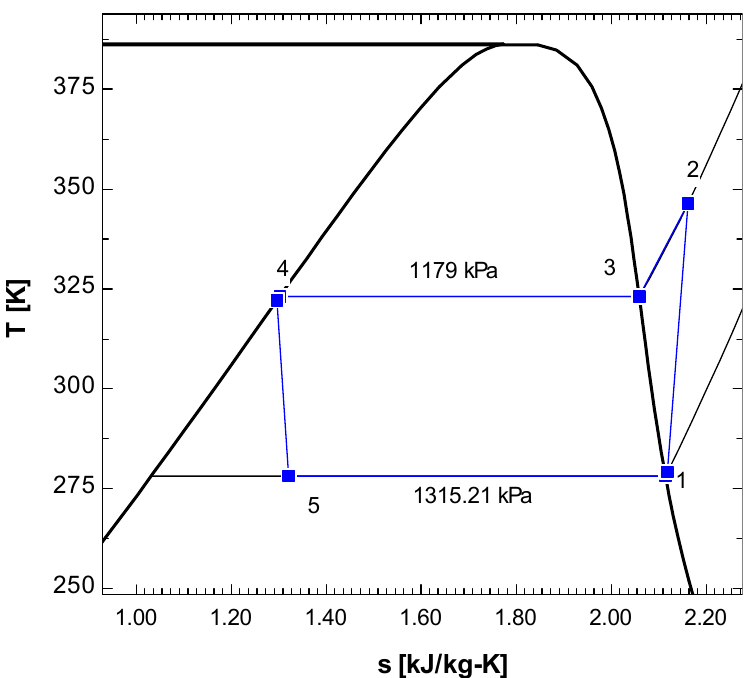
Figure 4 . T-s diagram of vapor compression refrigeration cycle running with R152a .